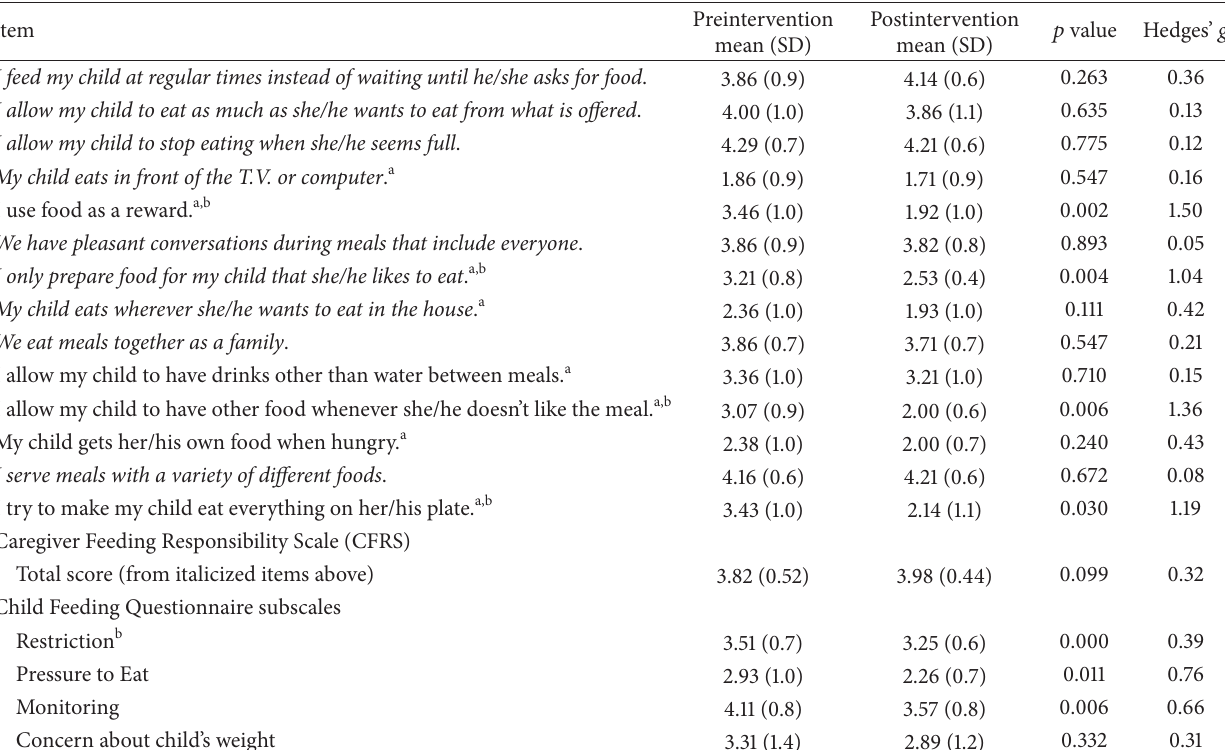
Table 1: Maternal feeding behaviors before and after the 90-minute class (Study